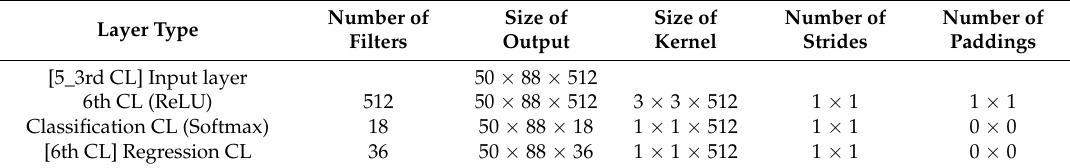
Table 3. Architecture of RPN in Figure 5 (CL indicates convolutional layer).